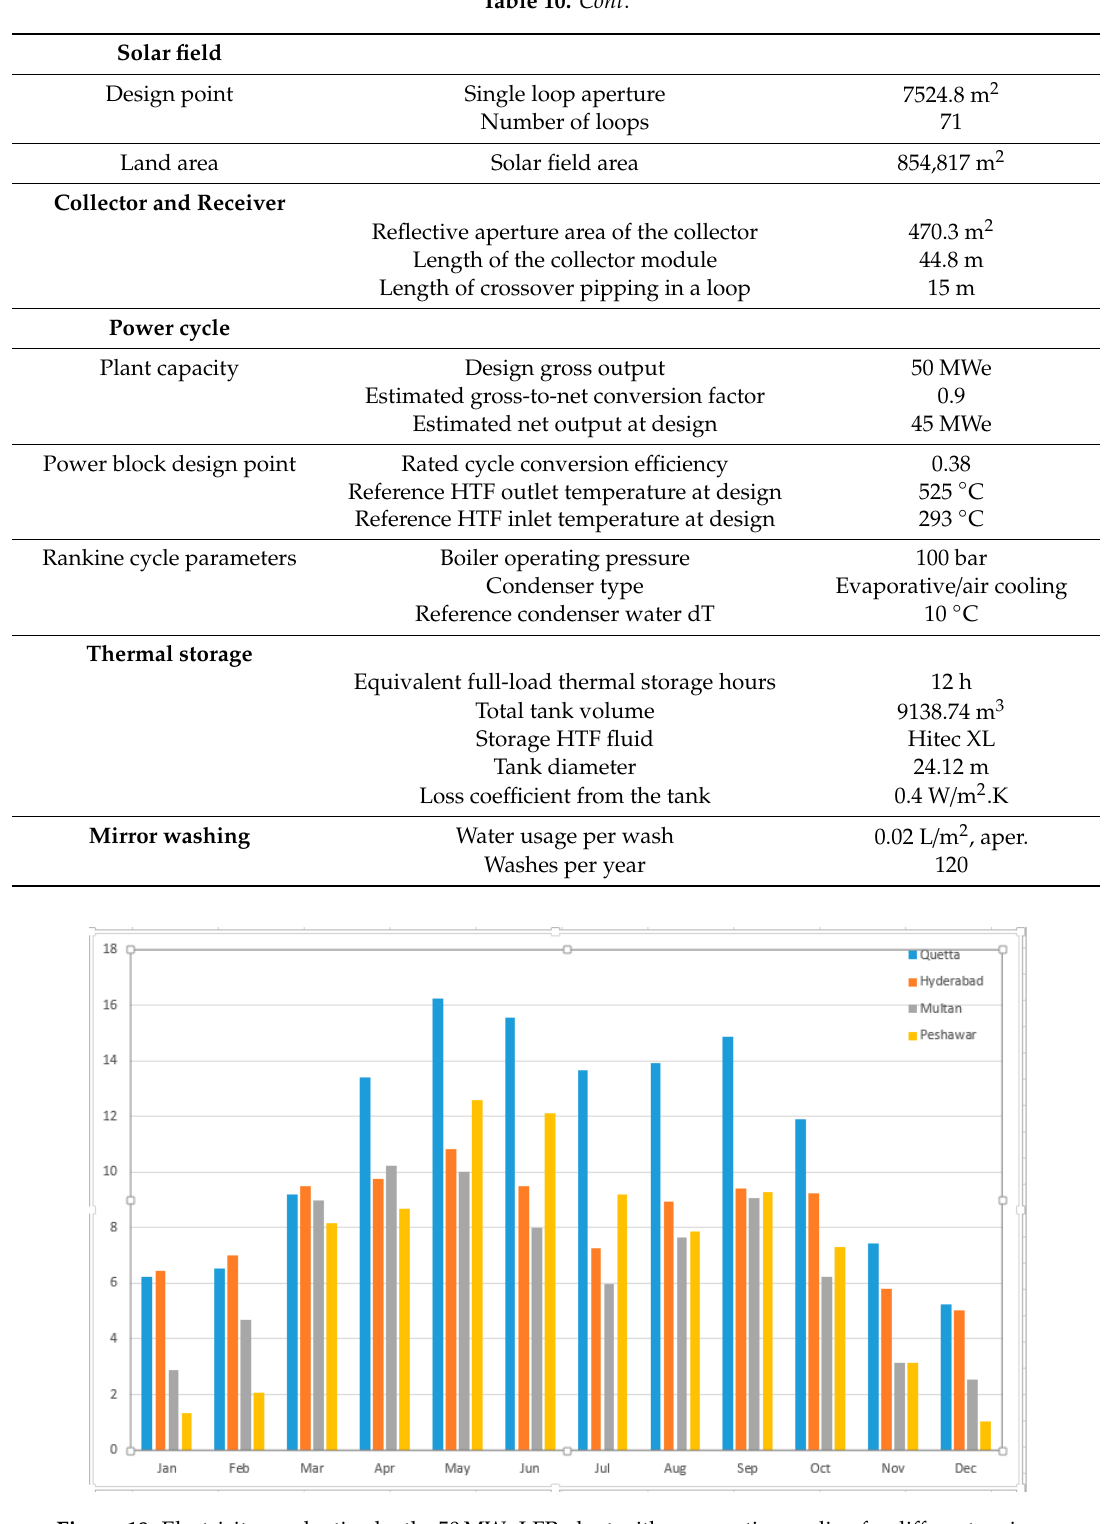
Figure 18. Electricity production by the 50 MWe LFR plant with evaporative cooling for di ff erent